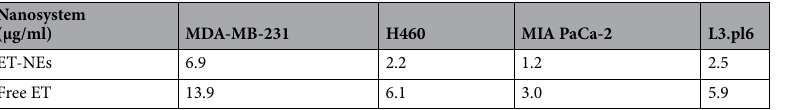
Table 2. Half maximal inhibitory concentration (IC50) of ET-NEs and free ET upon incubation with different cancer cell lines (lung (H460), pancreatic (MIA PaCa-2), pancreatic liver metastasis (L3.pl6)) for 24 h at 37 °C.